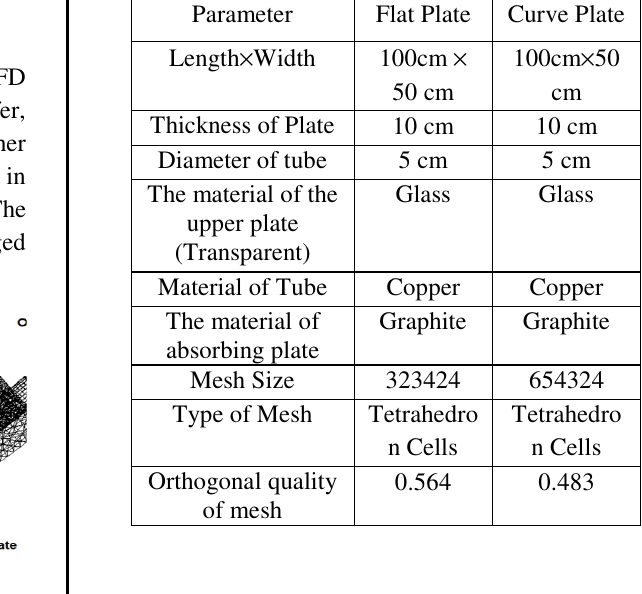
Table 1: Overall dimensions of geometries and mesh